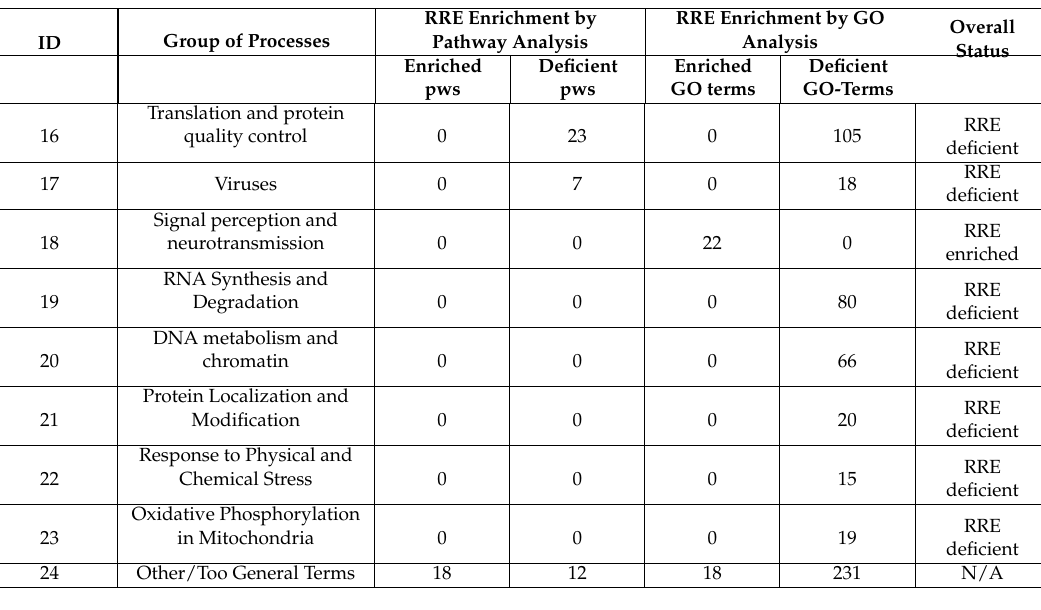
Table 7. RRE-enriched and deficient immunity-linked processes according to Gene Ontology (GO) and molecular pathway analysis ( evolutionary young